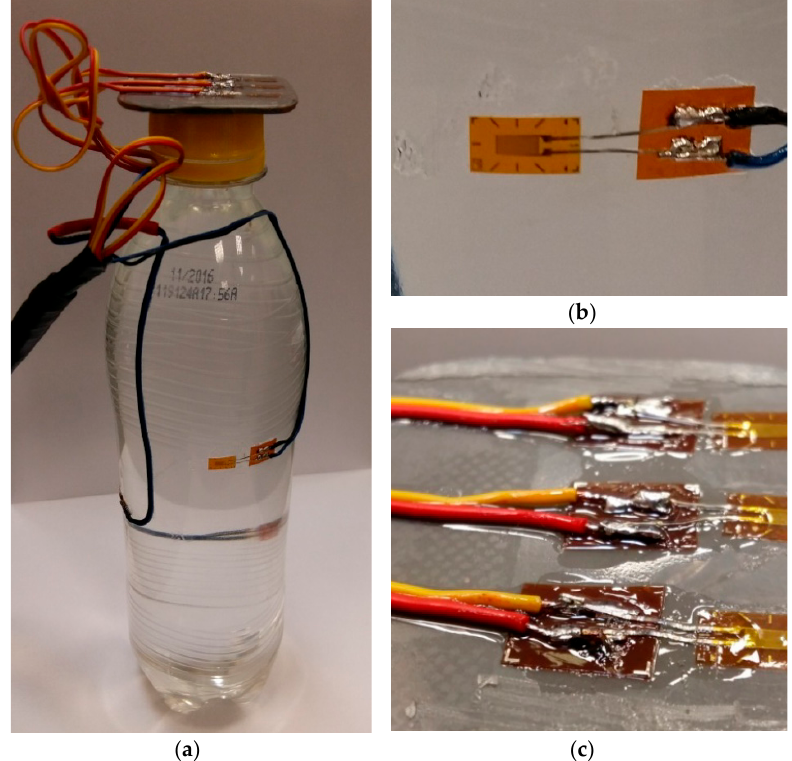
Figure 6. Configurations of the attached strain gauges on test container: ( a ) a bottle with strain gauges glued on three different heights; ( b ) a single strain gauge; ( c ) compensating strain gauges.